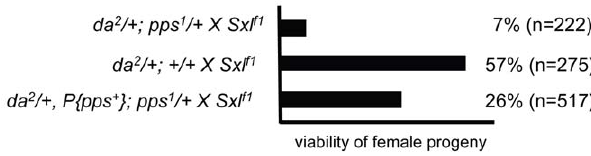
Figure 3. pps is a dosage-sensitive maternal modifier of Sxl . Synergistic genetic interactions lead to female lethality. In these assays, females of the indicated genotype were mated to Sxl f1 /Y and the resulting progeny scored. On the assumption that an equal number of male and female progeny will be generated from each cross, the percent female viability was calculated by comparing the number of females recovered with the number of males recovered. doi:10.1371/journal.pgen.1000872.g003 (n=222). Restoration of female viability by the genomic rescue